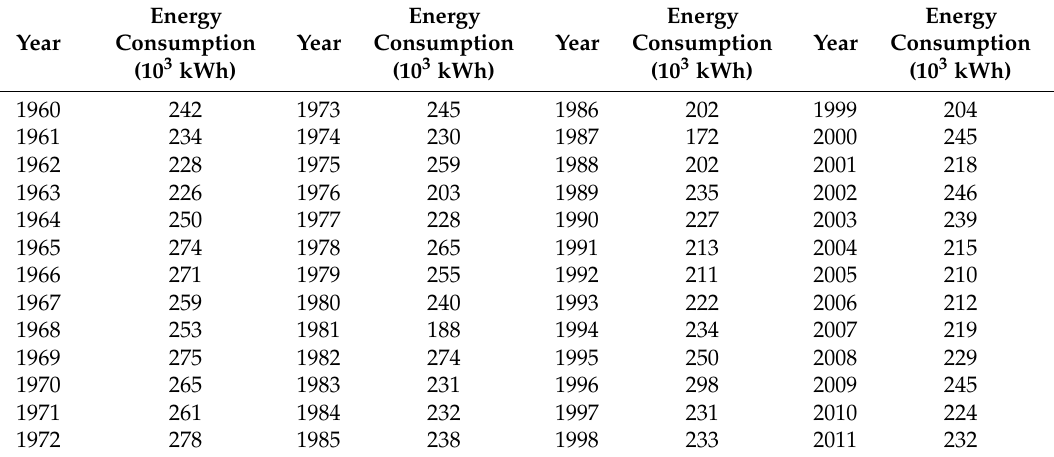
Table 5. Heating energy consumption in 52 years using the degree-day